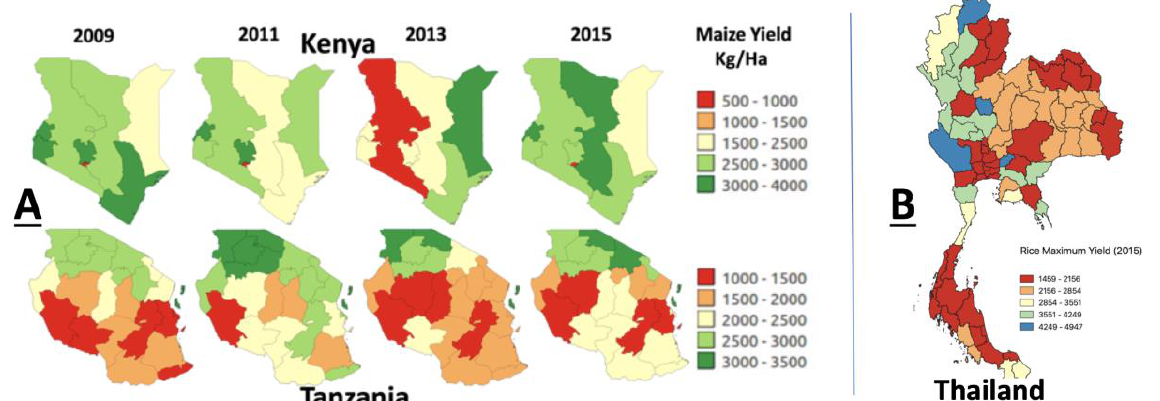
Figure 6 : Operational M-DSSAT system from the, crop yields obtained from the integrated RHEAS and M-DSSAT framework: A) Maize yields from Kenya and Tanzania; and B) Rice yields from Thailand. Table 1 : NASA products used in the RHEAS and